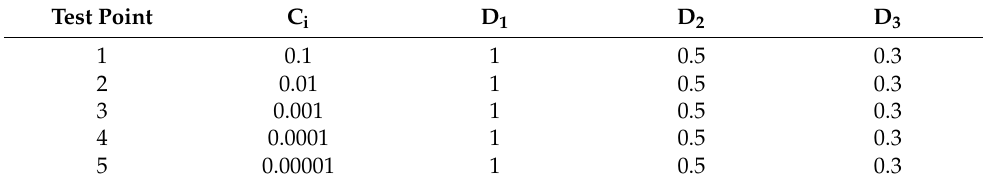
Table 6. Investigated values of the parameter C i in the MRD model.